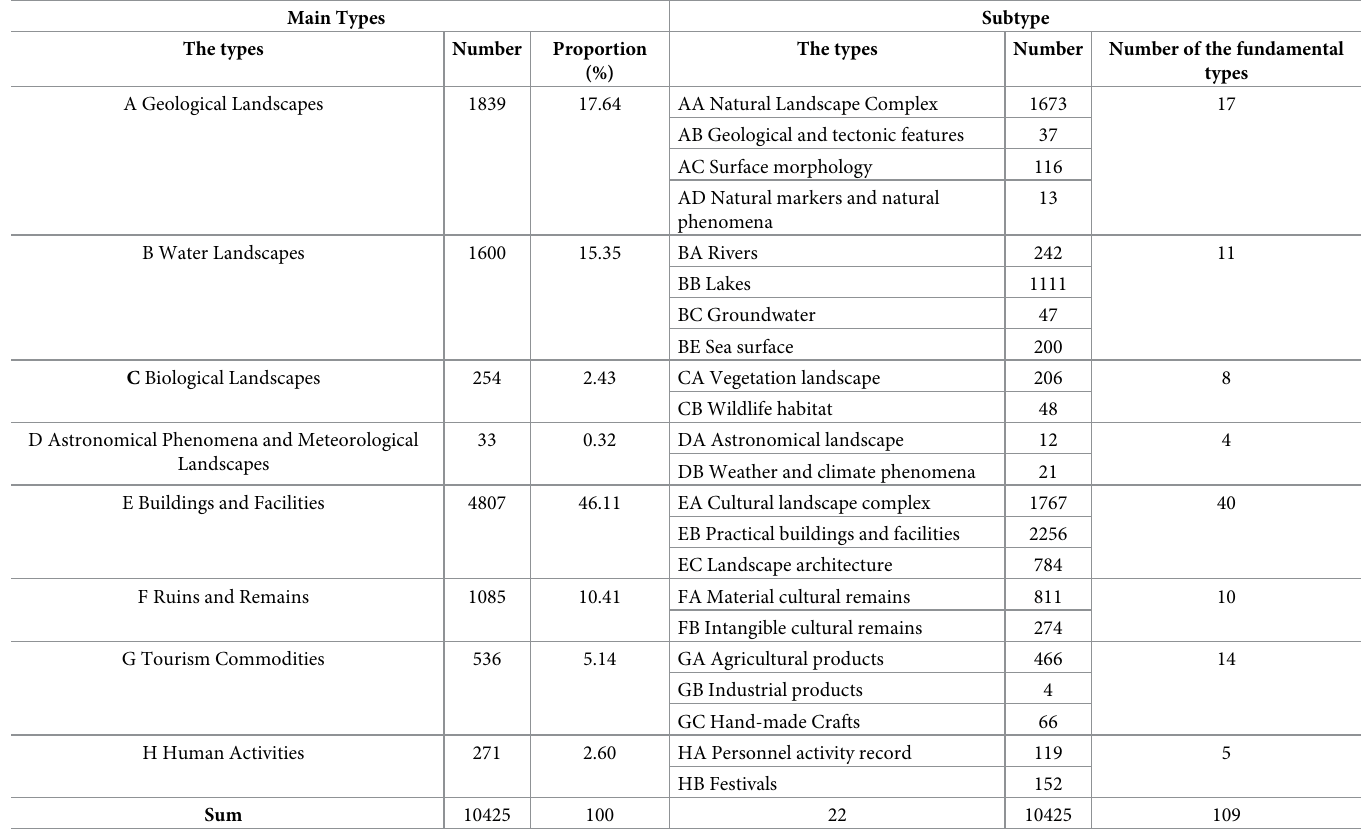
Table 1. The types and quantity of tourism resources on Hainan